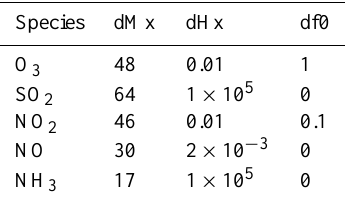
Table 7. The main characteristics of the dry deposited species with their names: dMx the molar mass of the model species, dHx the effective Henry’s law constant (Matm − 1 ) for the gas, and df0 the normalised (0 to 1) reactivity factor for the dissolved